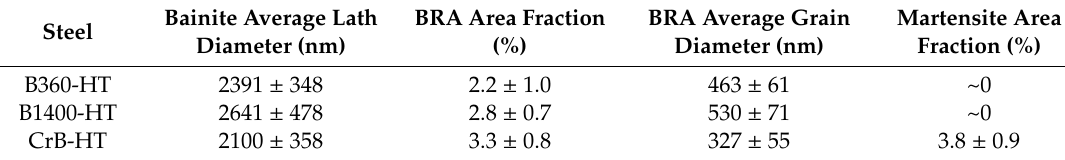
Table 4. The comparison of microstructural constituents in heat-treated samples.